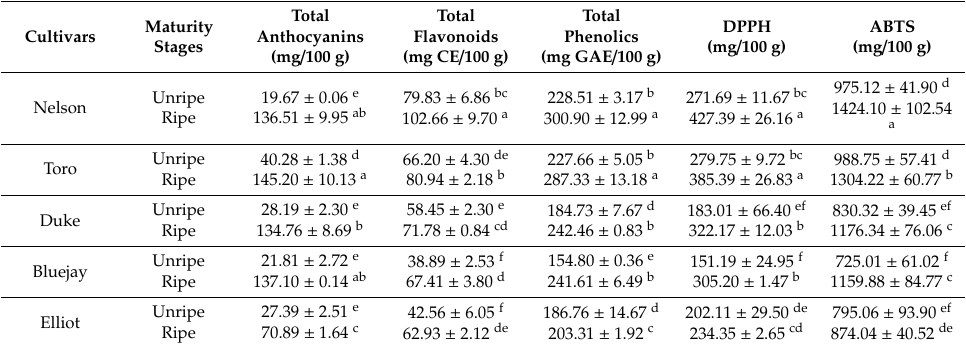
Table 3. Antioxidant content and activities of blueberry fruits at di ff erent maturity